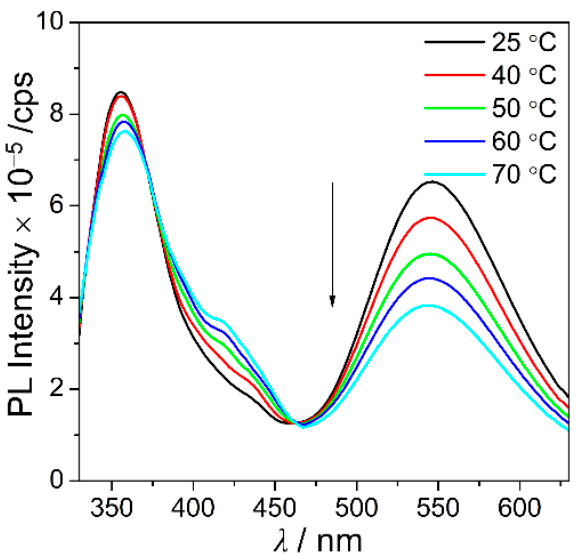
= 322 nm) as functions of ex